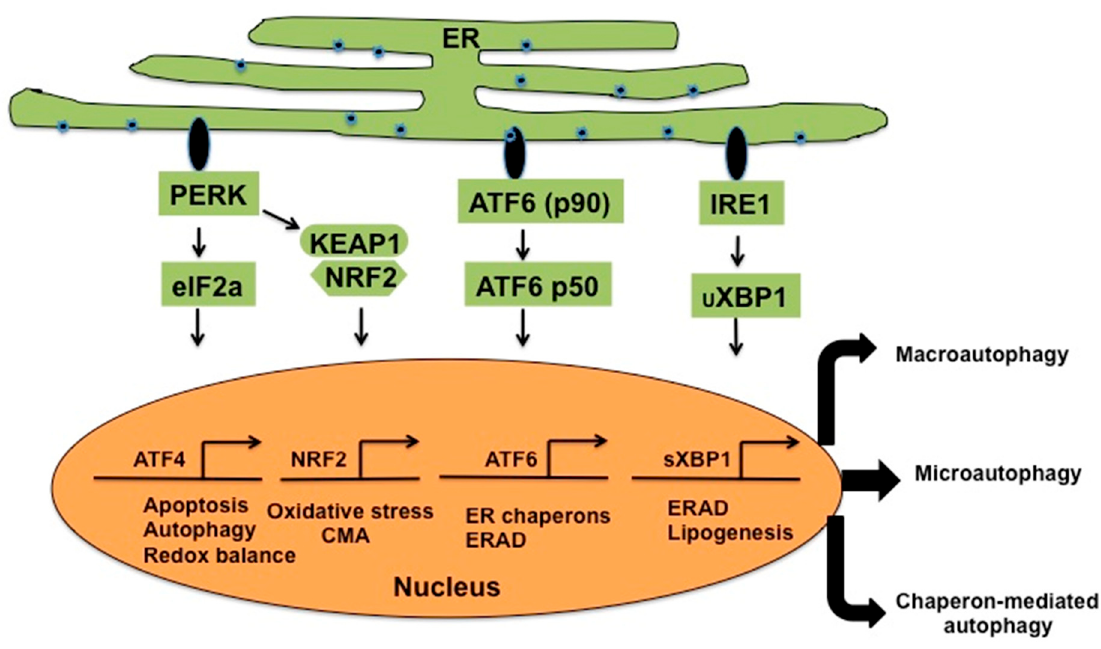
Figure 3. Schematic representation of unfolded protein response (UPR) associated with ER stress in HCV infection. The three ER stress sensors, protein kinase RNA (PKR)-like ER kinase (PERK), activating transcription factor 6 (ATF6) and inositol-requiring protein-1 (IRE1), activate gene expression that is involved in reducing ER-stress through a wide variety of mechanisms. PERK phosphorylates eukaryotic translation initiation factor 2A (eIF2a) to decrease translation while it activates activating transcription factor 4 (ATF4). ATF4 translocates into the nucleus to initiate transcription of genes involved in cellular apoptosis and autophagy. The ATF6 translocates to Golgi, where it is cleaved into an activate form. The active form of ATF6 translocates to the nucleus to activate genes involved in protein degradation and protein folding. The IRE1 decreases protein loads in the ER by enhancing mRNA degradation. The IRE1 axis also generates spliced versions of XBP1, which translocate to the nucleus to induce genes involved for protein degradation and lipogenesis.